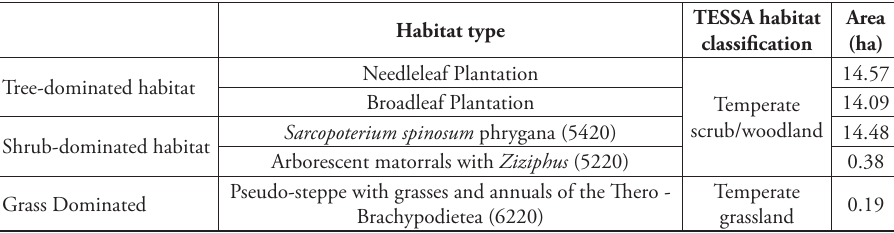
Table 1. Main habitat types at Rizoelia N.F.P, the corresponding habitat classification proposed by the TESSA toolkit and their extent in hectares.